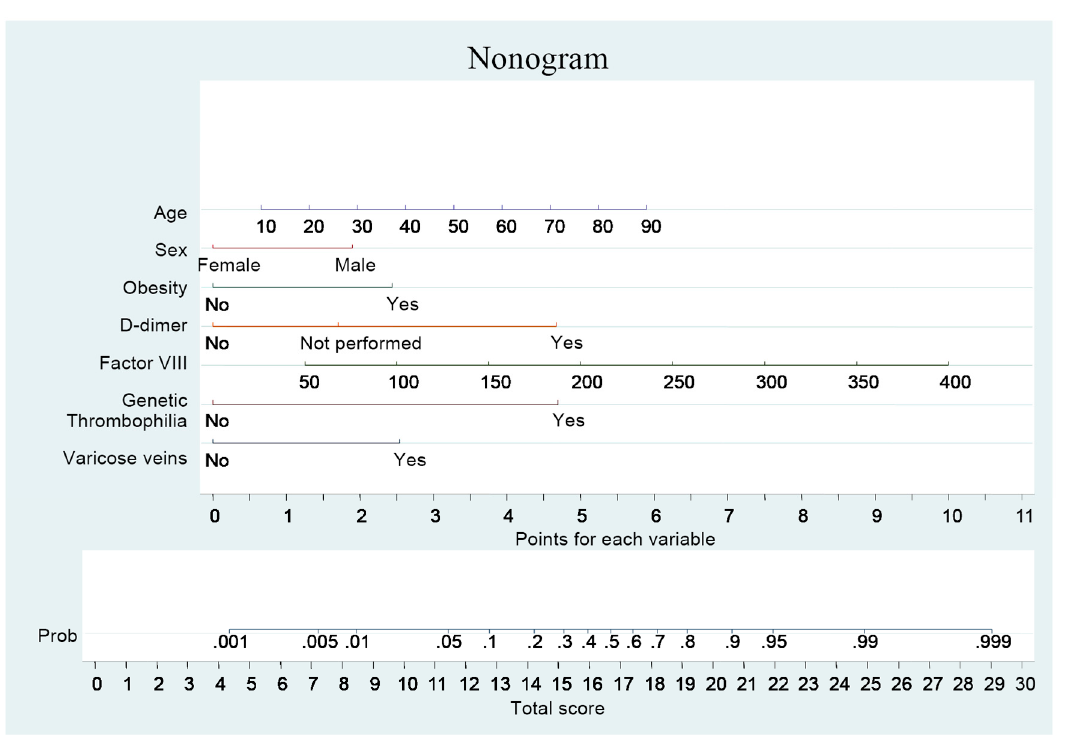
Figure 1. DAMOVES